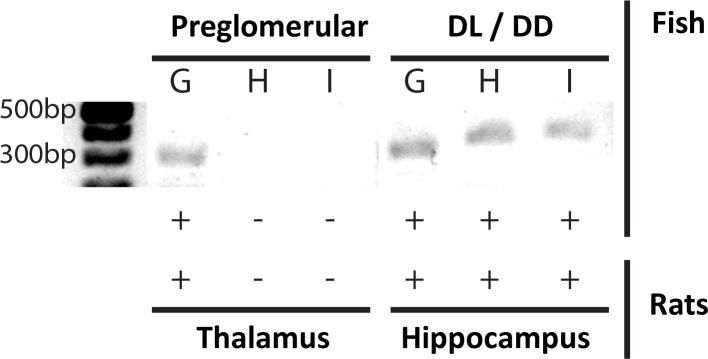
T-type Ca2+ channel expression profiles support PG thalamic homology.mRNA expression of G, H and I subtypes of the T-type Ca2+ channel α-unit, for PG (left) and the pallial DL-DD region (right) of A. leptorhynchus – compared with mRNA expression of the same subunits in the thalamus and hippocampus of rats (Talley et al., 1999). Only the α1G transcript of the T type Ca2+ channel (CaVT) is expressed in both PG and thalamic neurons; in contrast, all three transcripts are expressed in DL and hippocampal neurons. We propose that PG spike bursting (Figure 1B,C) is generated by the α1G T-type Ca2+ channels and that this is a highly conserved biophysical/genetic feature of neurons in the vertebrate thalamus.